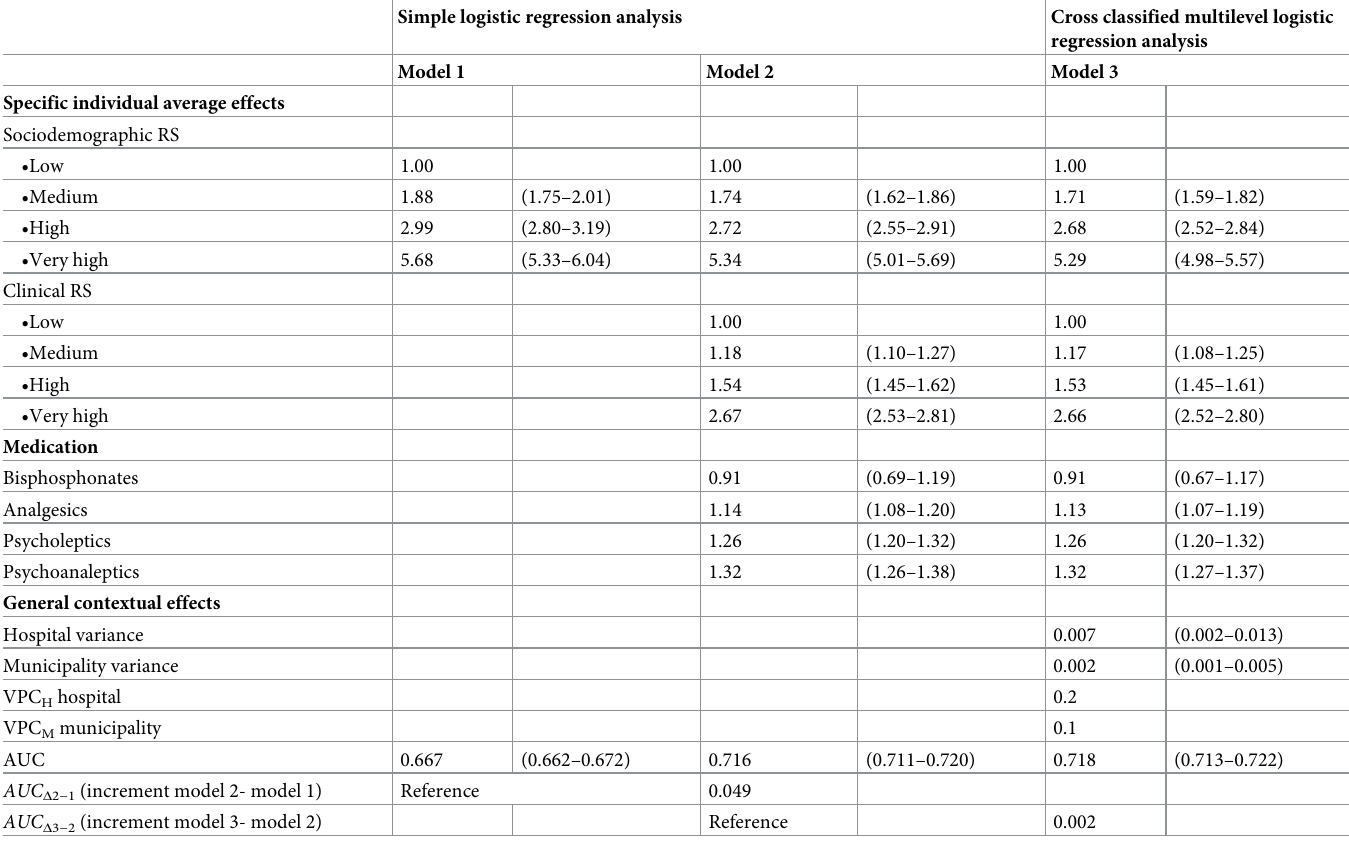
Table 2. Analysis of 1-year mortality after hip fracture in the Swedish hospitals. Simple logistic regression